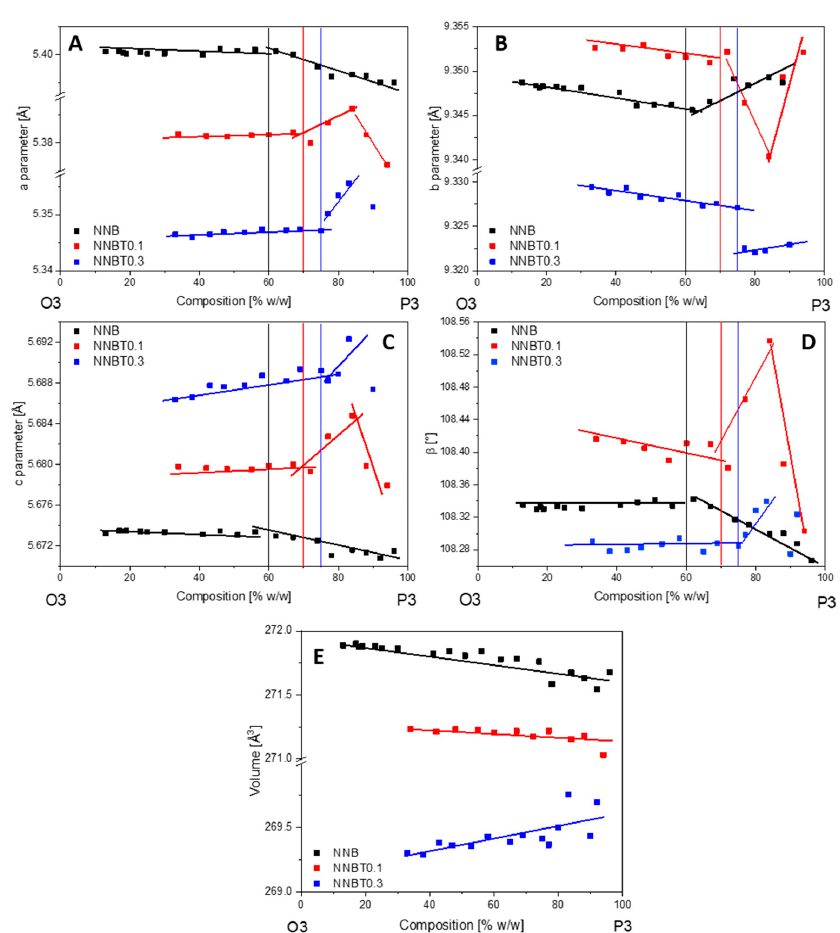
Figure 8. Changes of lattice parameters a, b, c and β ( A – D ) and unit cell volume ( E ) of the O3 phase for the compositions NNB, NNBT0.1 and NNBT0.3 in the two-phase region O3-P3.